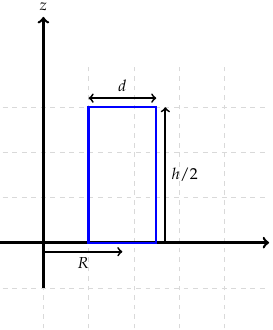
Figure A2. Parameterization of one coil of the SMES